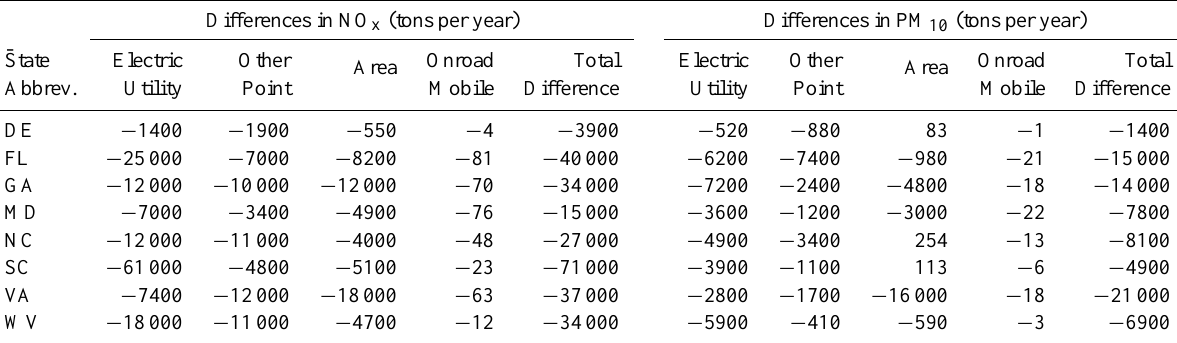
Table 5. Differences (Scenario 2 minus Scenario 1) in state- and sector-level emissions of NO x and PM 10 in the projected 2050 emission inventories (tons per